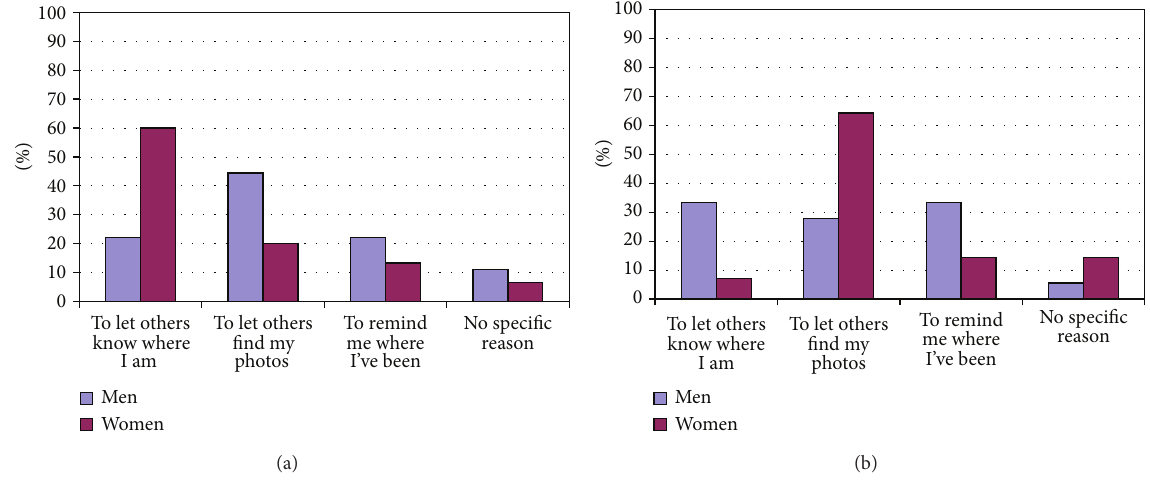
Figure 10: Reasons to use the geolocation feature: DN (a) versus DI